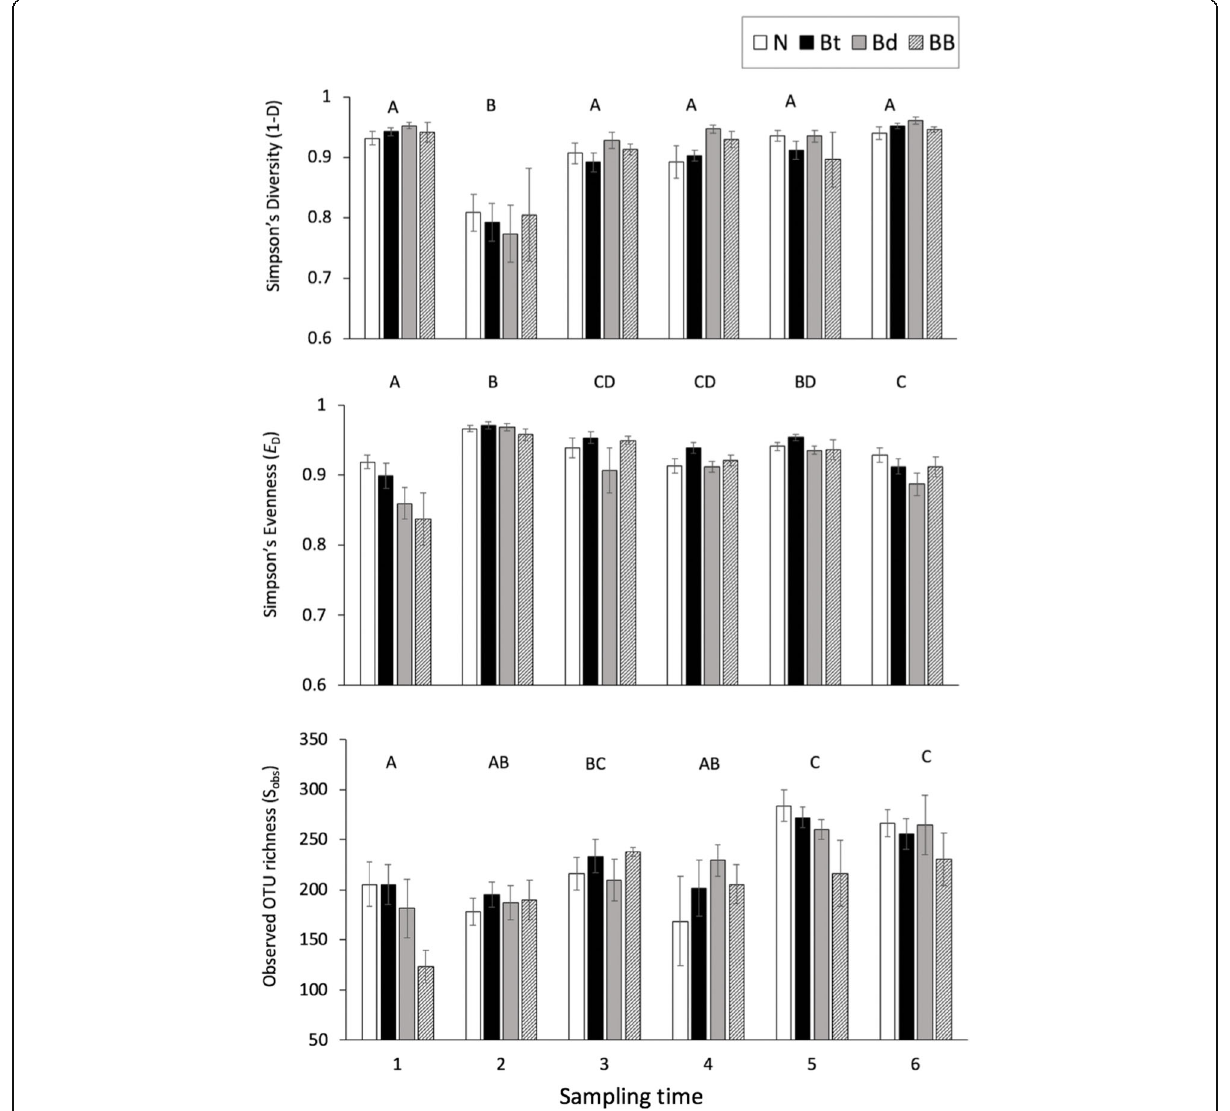
Fig. 2 Alpha diversity of cutaneous microbial communities across treatment groups and sampling time (reference Fig. 1). a Simpson ’ s diversity differed among sampling time but treatment did not have an impact. b Simpson ’ s evenness ( E D ) differed over treatments and time. c Observed OTU richness (S obs ) differed across sampling time but not treatments. The legend is applicable to all biodiversity figures. Letters denote significant differences among sampling times. Repeated measures ANOVA statistics are listed in Table 1. Values are the mean (± s.e.) of the